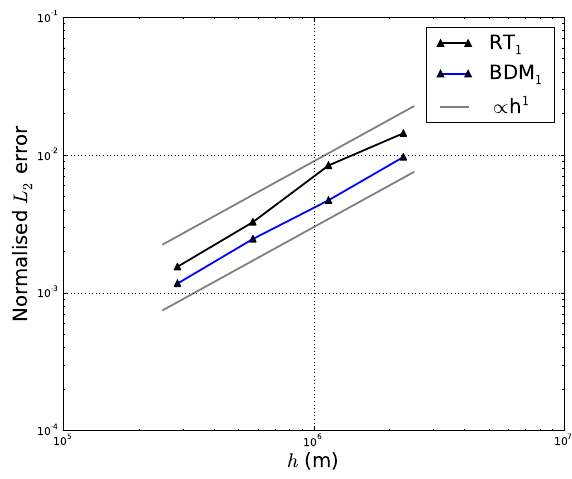
Fig. 14. Mountain nonlinear shallow water test case on the sphere: L 2 -error of surface height field D + b (compared to reference solution) versus mesh size h .